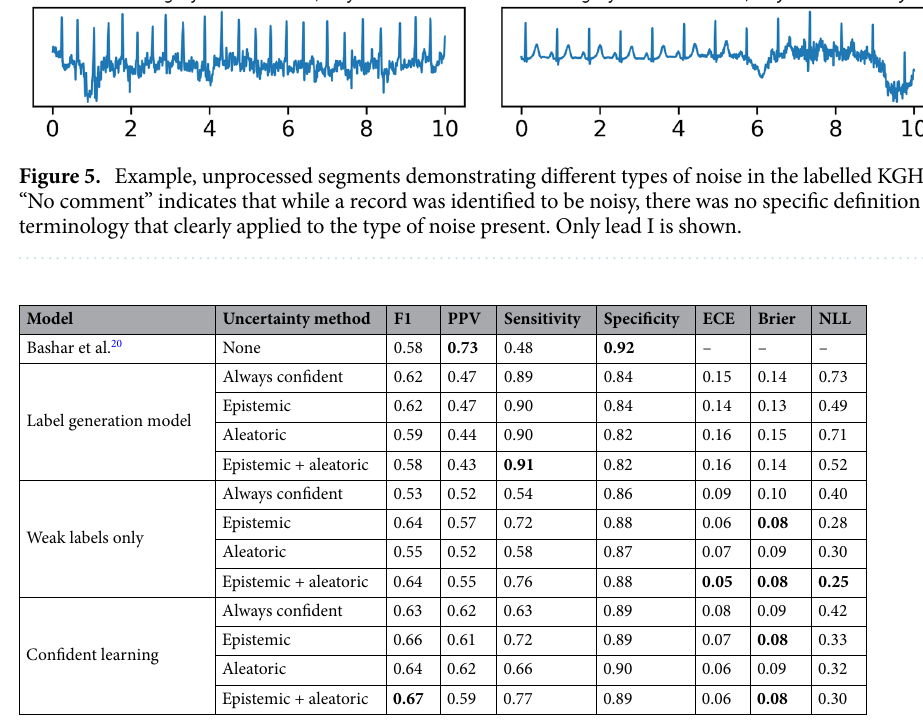
Table 1. Classification and calibration metrics for the baseline and all three deep learning models on labelled sinus rhythm and AF class samples from the KGH dataset. PPV positive predictive value or precision; ECE expected calibration error; NLL negative log-likelihood. The best scoring model for each metric is shown in